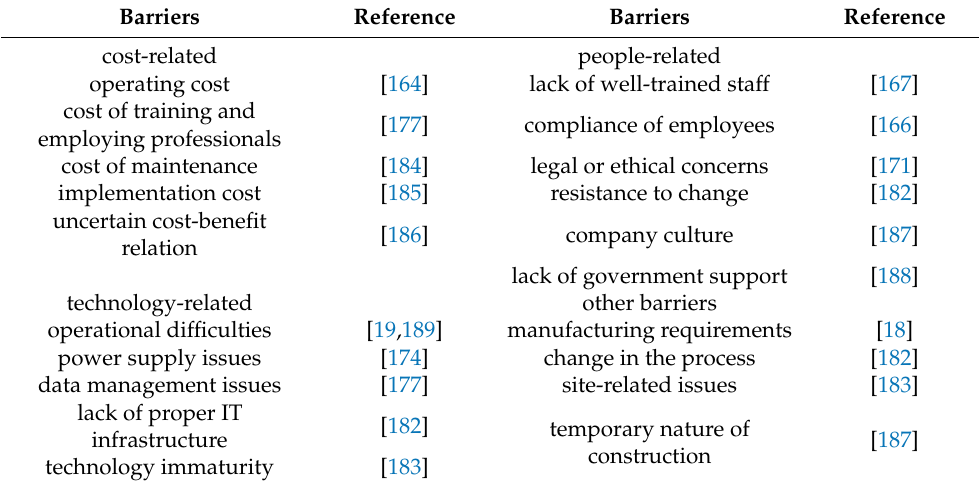
Table 7. Barriers to digital technology adoption according to construction